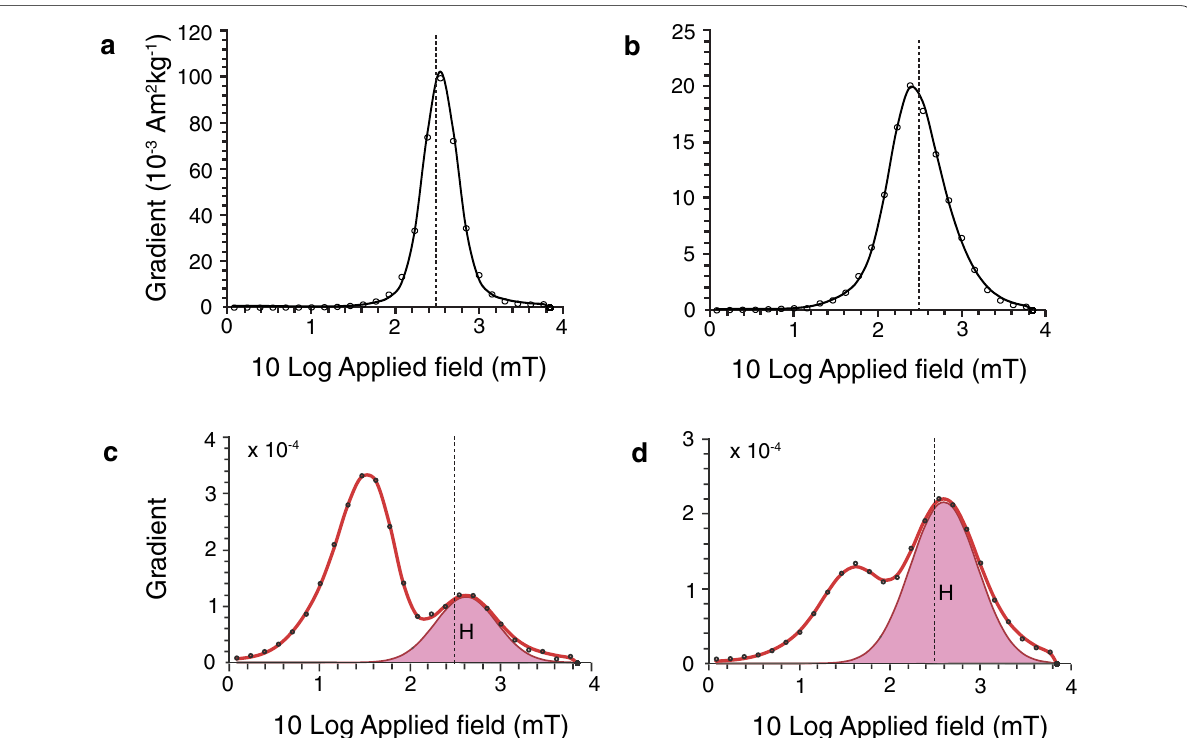
Fig. 4 First derivative of IRM acquisition (gradient) curves and hematite components for 7‑T maximum applied fields. Results for hematite pigments in a decorative ‘print stone’ from the Mount McRae Shale Formation, Western Australia (Abrajevitch et al. 2014): a hematite print stone pigment (sample pps11) and b uniform pigment (sample TOM07). Results from Abrajevitch et al. (2015) for: c Paleogene limestone 21 cm above the K–Pg boundary at Bottaccione Gorge, Italy, and d limestone 46.5 cm below the boundary. Abrajevitch et al. (2015) identified five components; for clarity, only the hematite (labelled H) component of interest here is shown. Dashed vertical lines represent the 300‑mT cut‑off